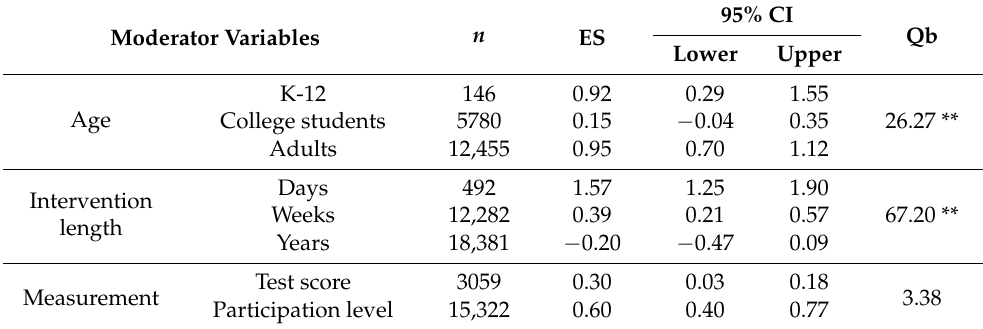
Table 2. Effect sizes by moderator variables in the meta-analysis.